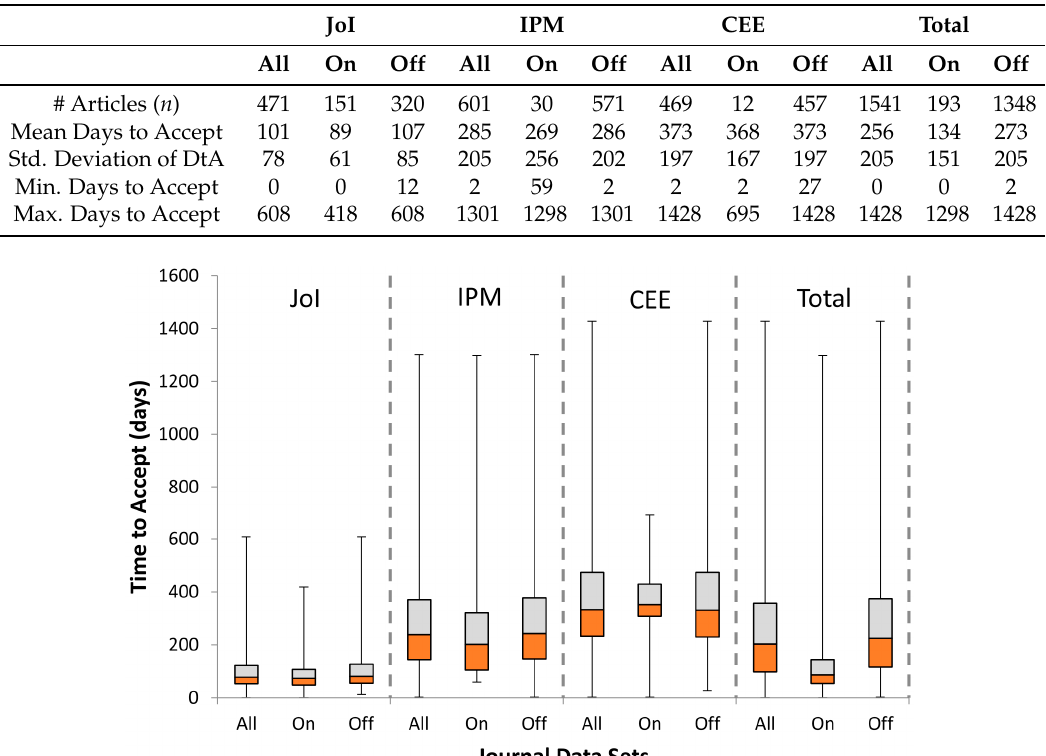
Table 1. Descriptive statistics of three journal data sets and of their aggregate.